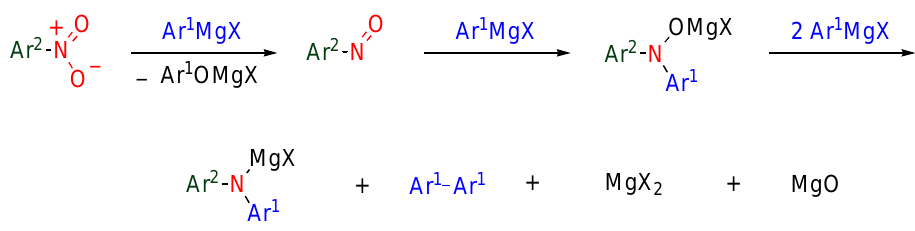
Scheme 7. Reaction of nitroarene and aryl Grignard reagent.